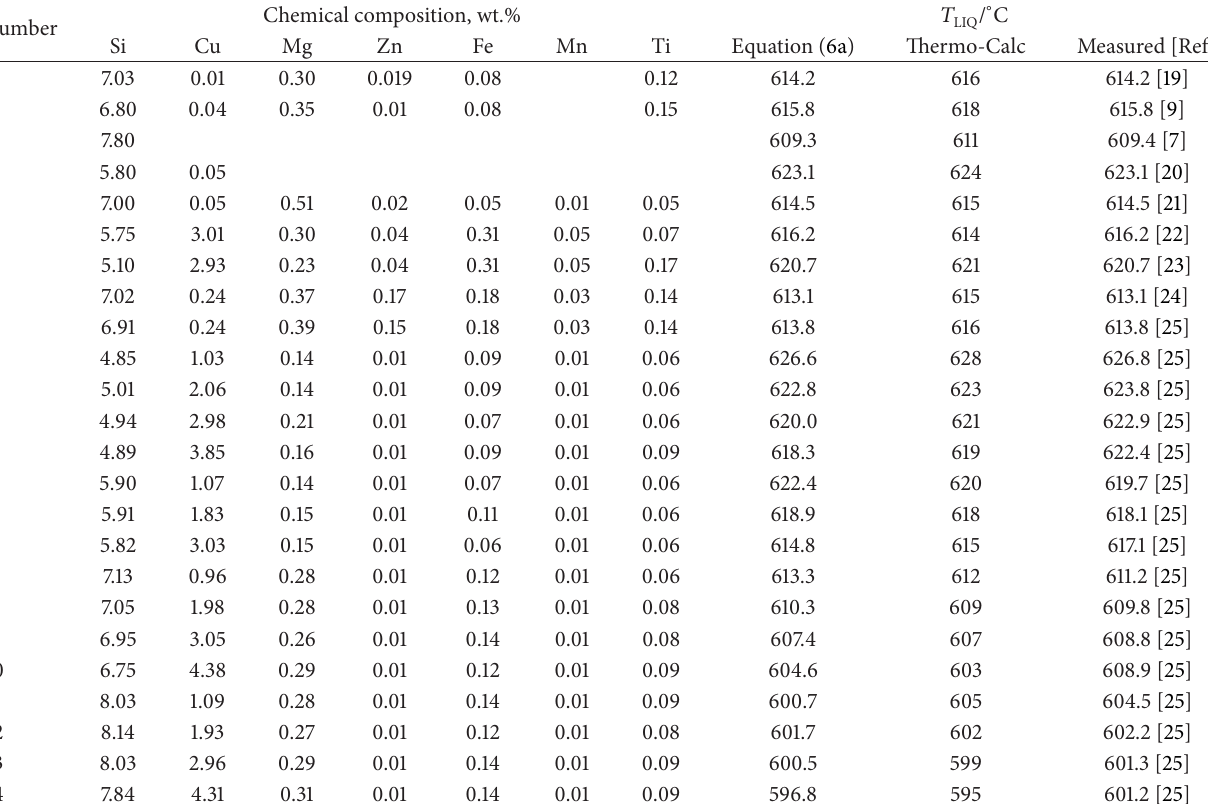
Table 2: Chemical composition of aluminum alloys (wt.%) calculated liquidus temperatures using (6a), Thermo-Calc, and the measured.